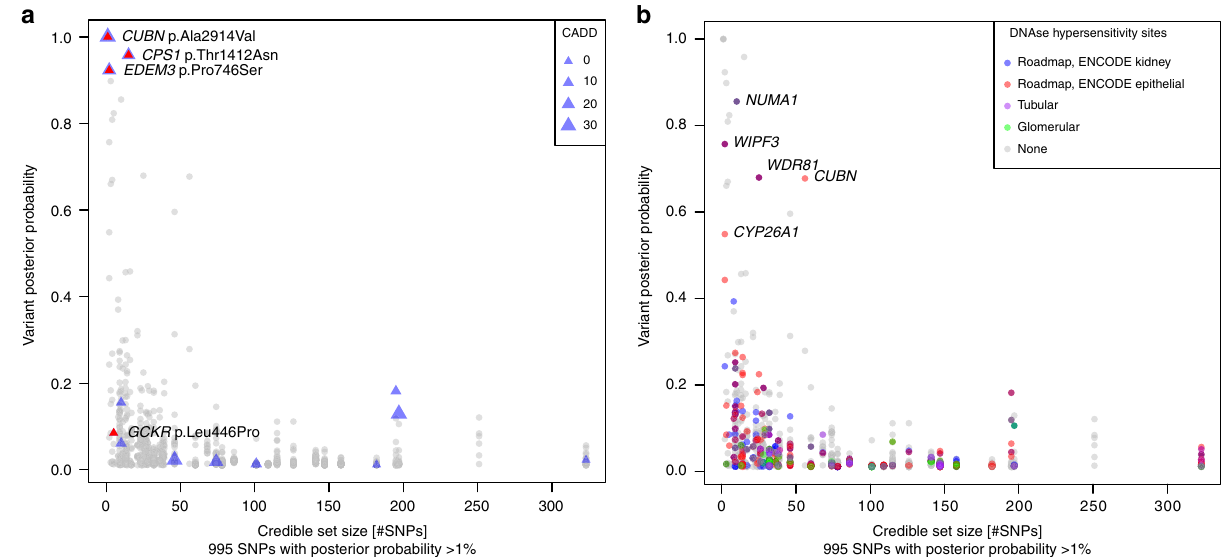
Fig. 5 Fine-mapping and functional annotation of potentially causal variants. Overview of 995 SNPs with a posterior probability of association with urinary albumin-to-creatinine ratio (UACR) of >1%. The x -axis indicates the 99% credible set size and the y -axis the SNPs ’ posterior probability of association. In panel a , missense SNPs are marked by triangles, with size proportional to the SNP CADD score. In panel b , SNPs are color-coded with respect to location in regulatory regions of speci fi c kidney tissues. The labels show the closest gene, and are restricted to variants mapping to small credible sets ( ≤ 5 SNPs), or to variants with high individual posterior probability (>0.5) of driving the association signal. For the CUBN locus, a credible set was computed for